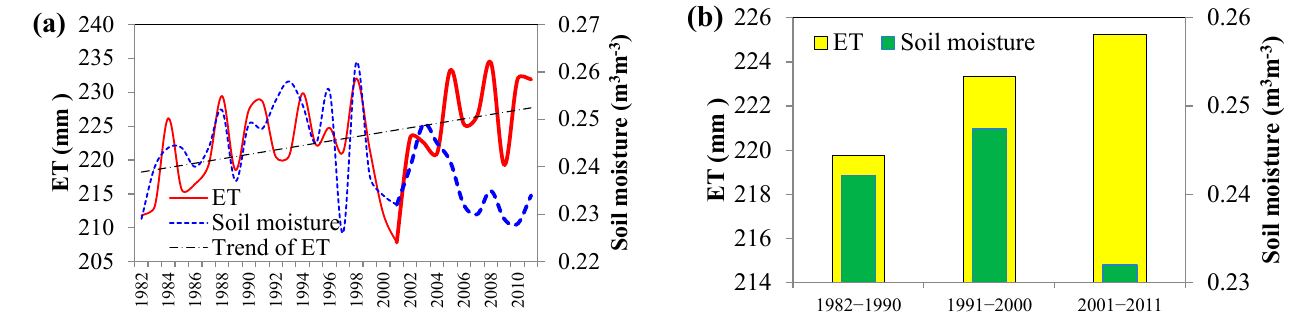
Figure 4. The changes in regional-mean summer ET and soil moisture on interannual ( a ) and interdecadal ( b ) scales.